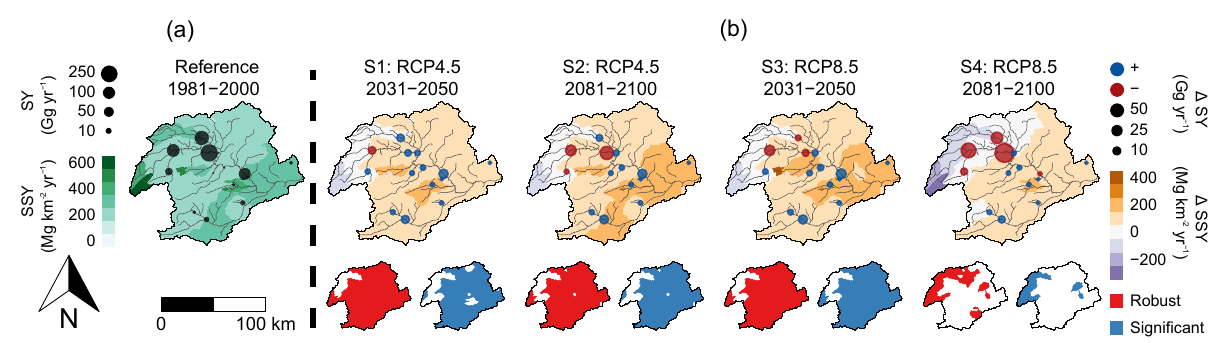
Figure 5. Ensemble average sediment yield (SY) at the reservoirs (dots, Ggyr − 1 ) and average hillslope erosion (SSY) per subcatchment (Mgkm − 2 yr − 1 ) for the reference scenario (a) and changes between the reference scenario and the four future scenarios (b) . For the future scenarios, the SY is presented as an increase (blue) or a decrease (red).